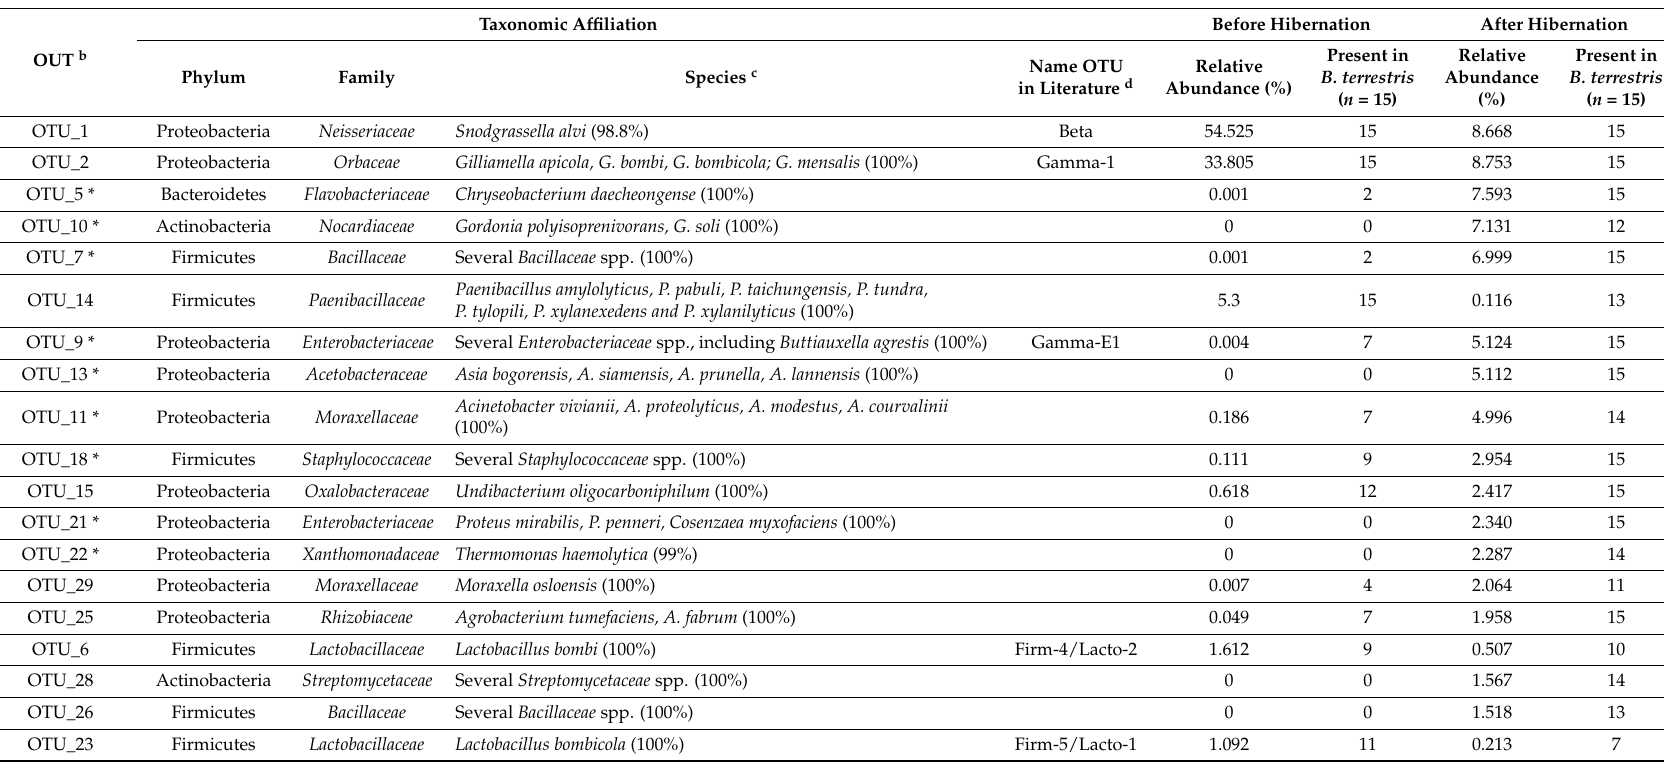
Table 1. Mean relative abundance and prevalence in indoor-reared Bombus terrestris queens ( n = 15 per treatment) of the main operational taxonomic units (OTUs) found in this study a